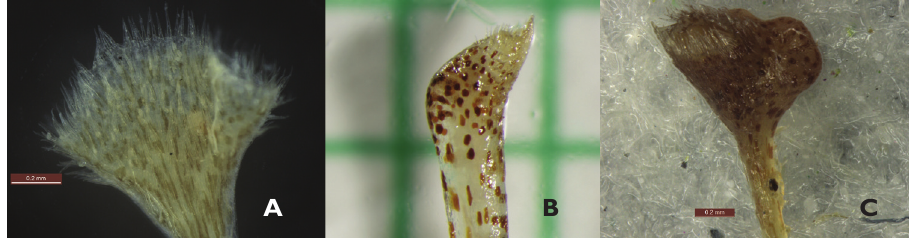
A CB Figure 6. Stigma A Funnel-shaped in Scaphochlamys endauensis B Beak-like in Scaphochlamys biloba C Capitate in Borneocola petiolatus . (Photographs by A & C N.M. Aidil, B Y.Y. Sam) narrowly obovate, white, light yellow or green, spreading laterally, lined with translu- cent veins from base to apex, covered with glandular hairs on adaxial surface. Label- lum obovate, flat, bilobed distally, rarely entire, translucent veins spread from base